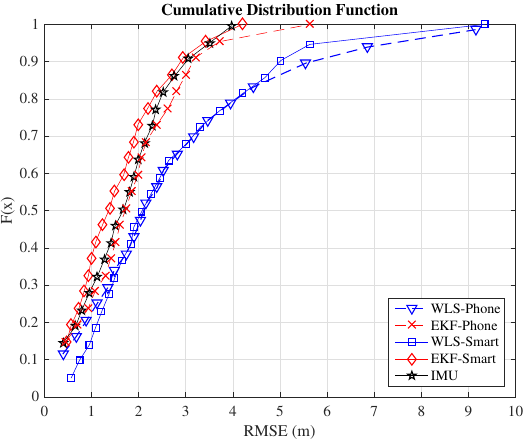
Figure 10. CDF of the positioning estimation error in Path